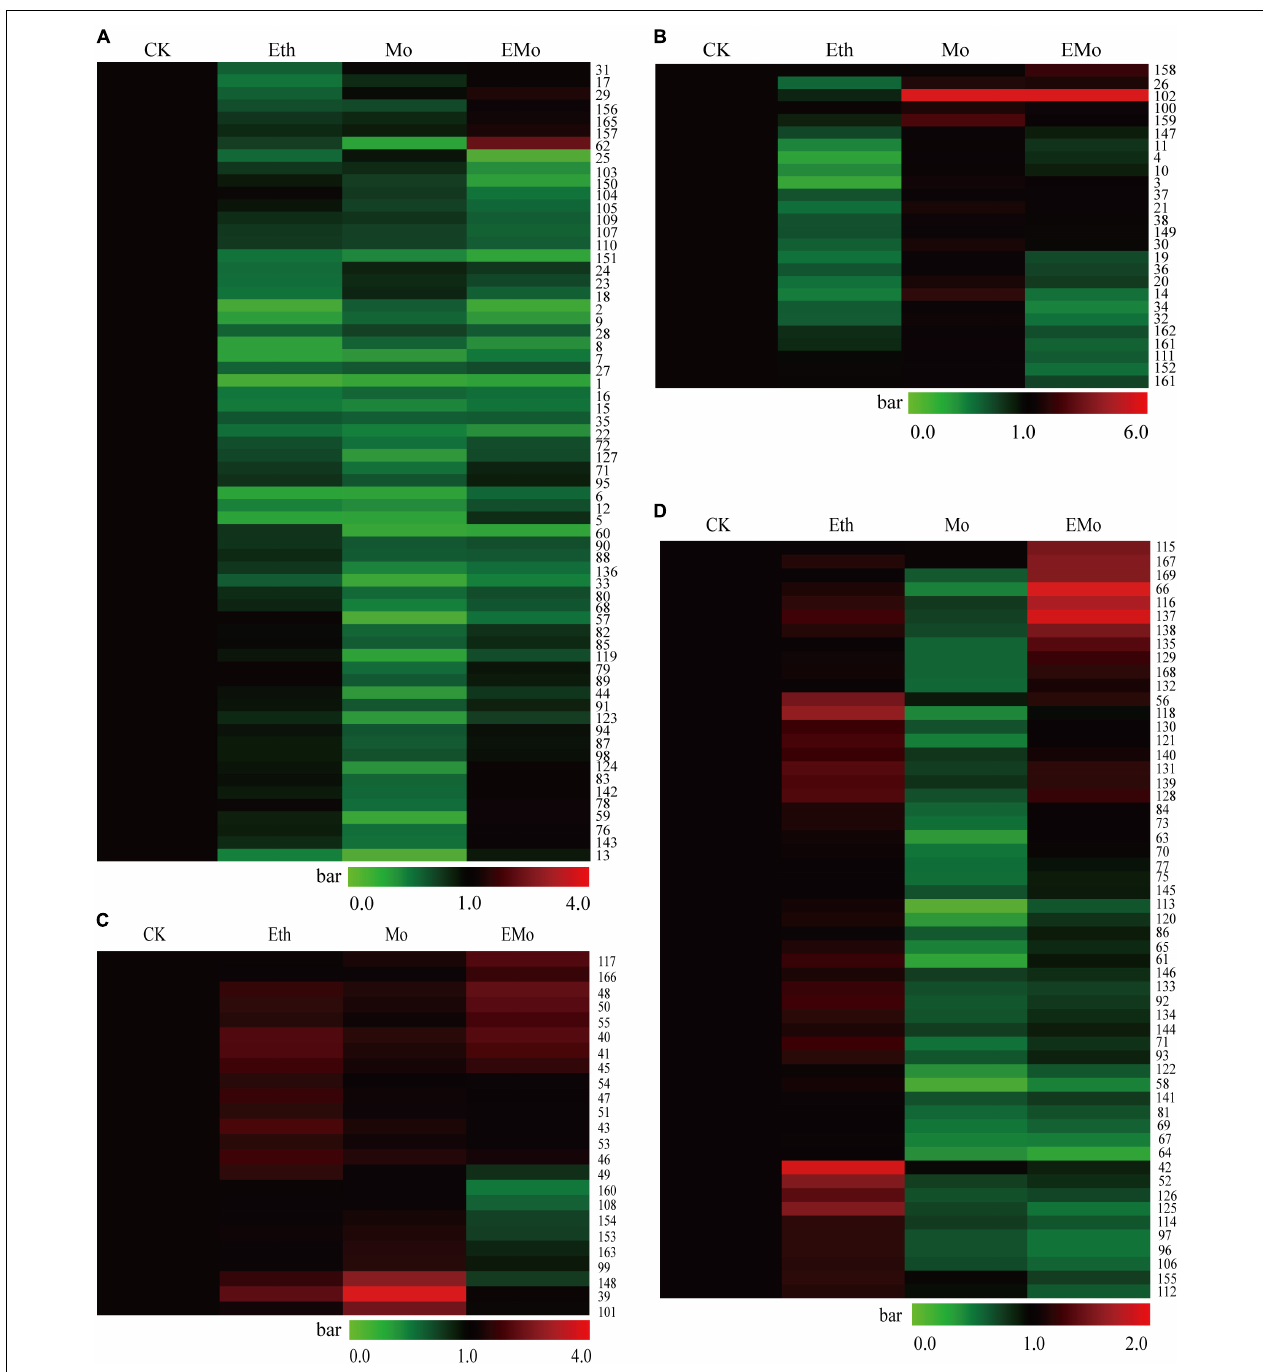
FIGURE 3 | Cluster of the identified DEPs among the different treatments. A hierarchical cluster of the identified 169 DEPs is presented. In cluster (A) , the proteins were reduced after Eth and Mo treatments. In cluster (B) , the proteins were reduced by Eth but induced by Mo. In cluster (C) , the proteins were induced after Eth and Mo treatments. In cluster (D) , the proteins were reduced by Mo but induced by